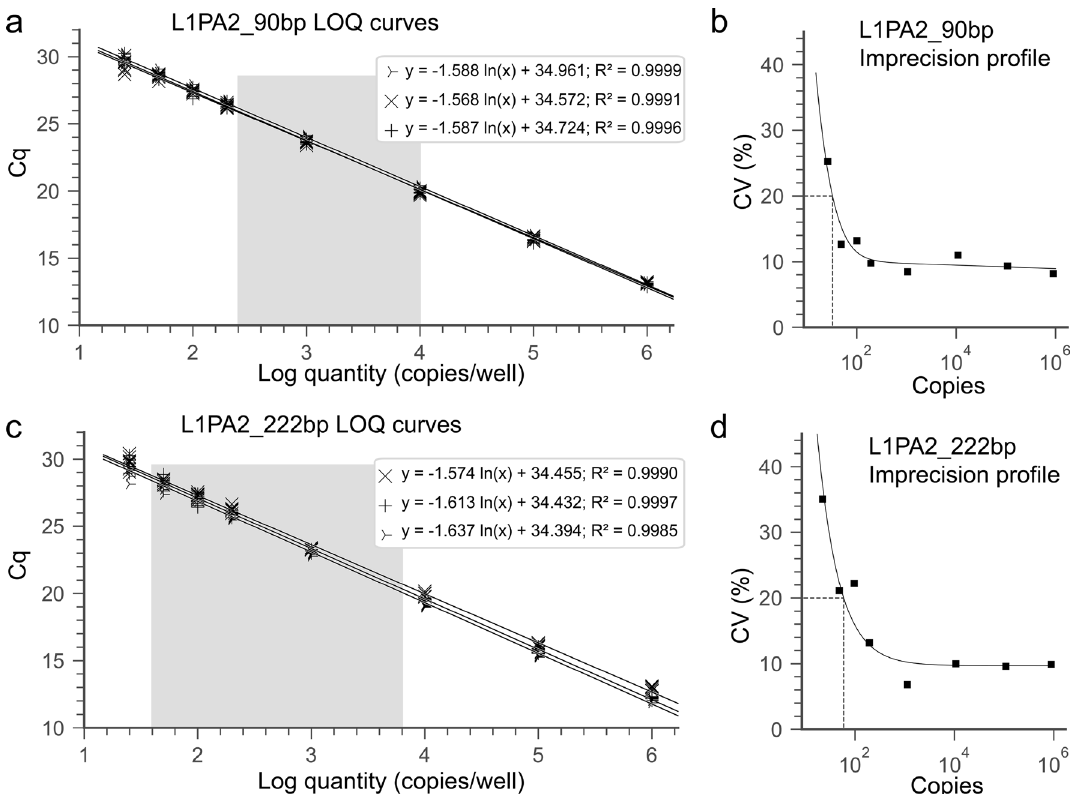
Figure 1. Standard curves and imprecision profiles for the L1PA2_90bp assay ( a, b ) and the L1PA2_222bp assay ( c, d ). Three independent standard curves, with septets per concentration were prepared for each assay. The imprecision profiles were calculated with the formulas: σ 2 = 31.37 + 0.011 × U 1.975 and σ 2 = (6.10 + 0.097 × U) 2 for the 90 bp ( b ) and 222 bp assay ( d ), using the R ‘VFP’ package (v1.2). The grey area indicates the quantification range of cfDNA concentrations in this study. Cq quantification cycle, LOQ lower limit of quantification, CV coefficient of variation. The figures were produced using the Python (v3.7.6) 28 libraries matplotlib (v3.1.1) 29 , and seaborn (v0.9.0) 30